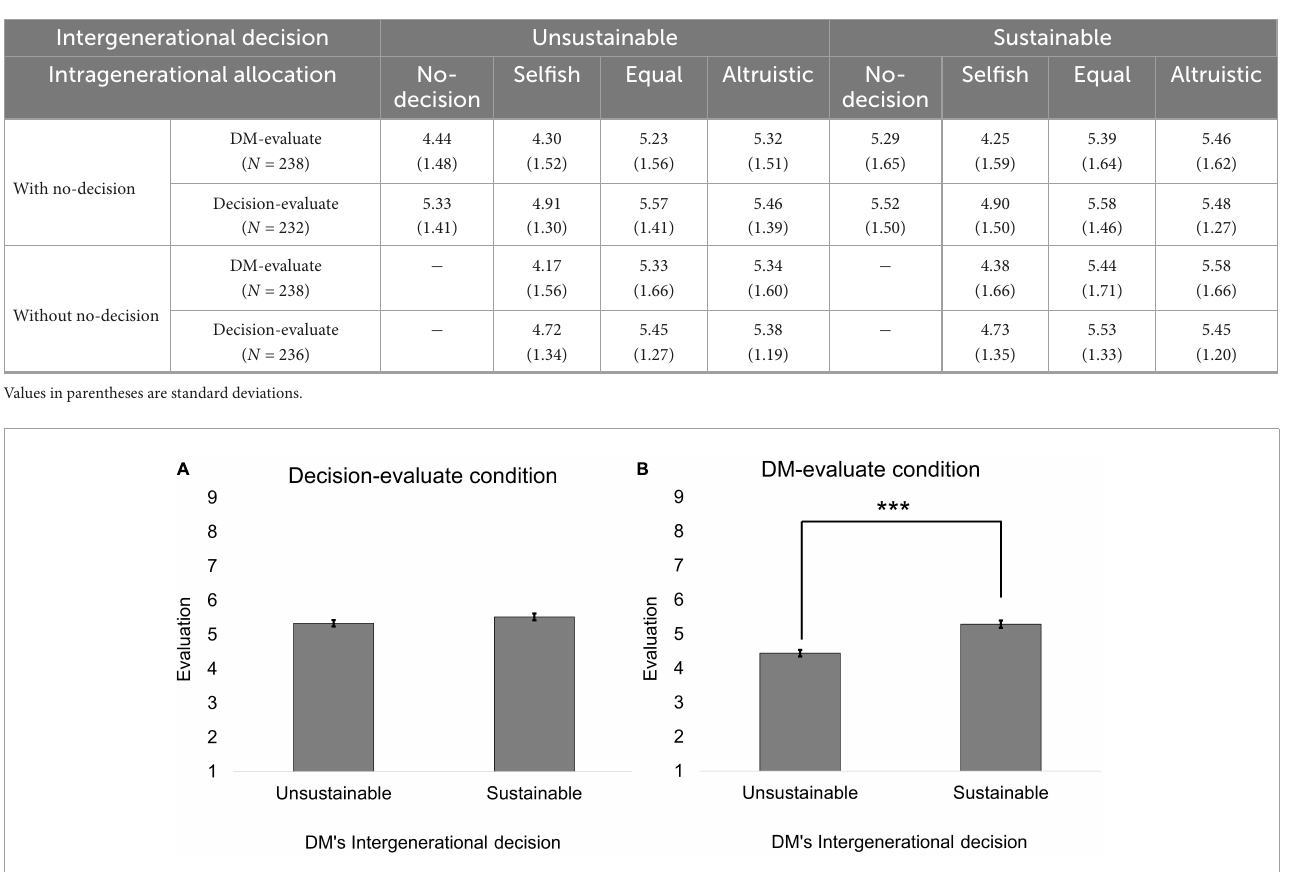
FIGURE2 The baseline evaluation in the no-decision condition (Study 1). (A) Is the evaluation in the decision-evaluate condition. (B) Is the evaluation in the DM-evaluate condition. Error bars represented the standard errors. Different from the main text, sample means were shown. The asterisks indicate Holm-corrected statistical significance based on the simple main effect analysis of the sub-sample. *** p <